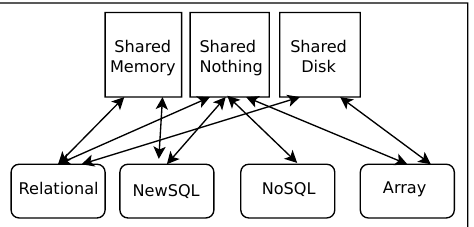
Figure 2. Available choices in adopting parallel architectures and data models for PCDM systems